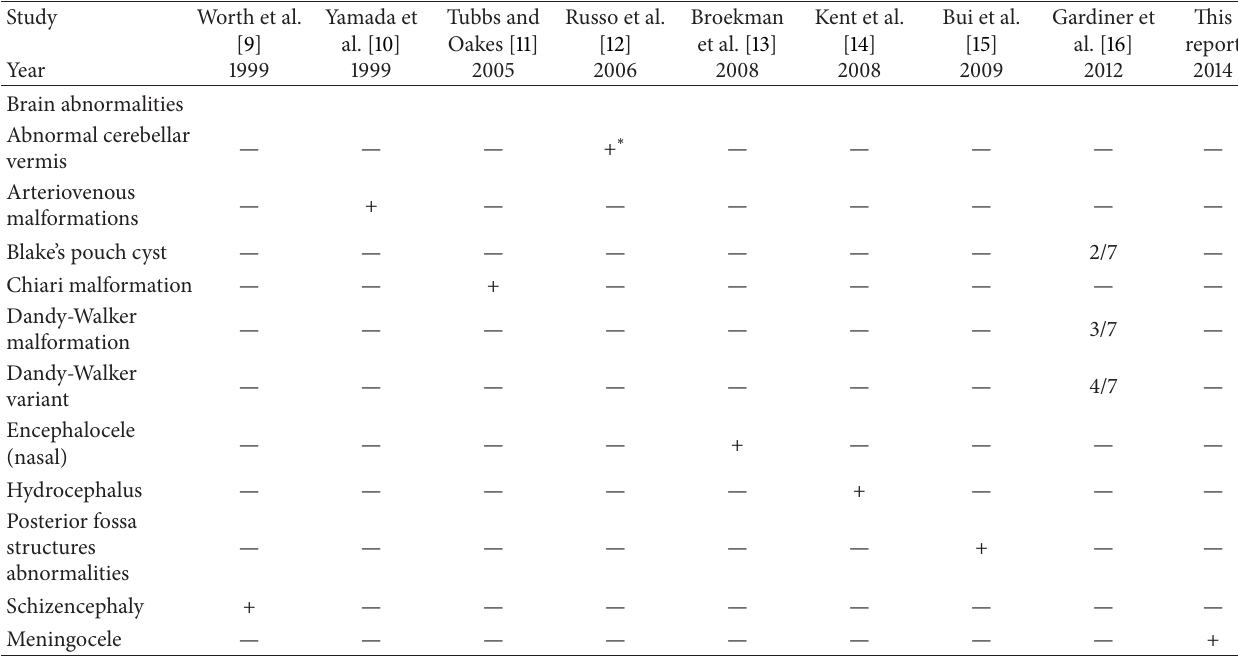
Table 1: Central nervous features associated with